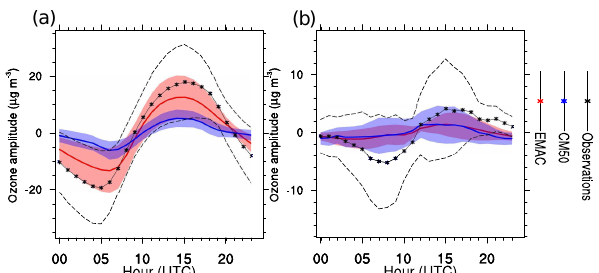
Figure 10. Diurnal cycle amplitude of ozone in µgm − 3 for (a) all non-mountain stations and (b) all mountain stations for June 2008. The observations are shown in black, while EMAC is shown in red and CM50 in blue. The dashed lines indicate the standard deviation over all stations of the observations, while the coloured polygons display the standard deviation of the simulation data.